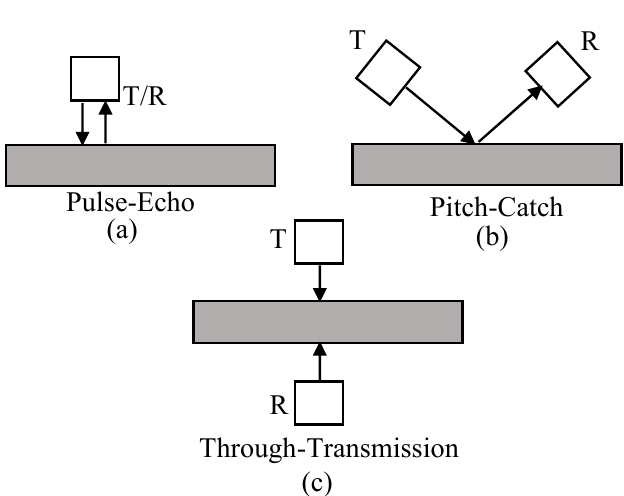
Figure 1. Three most common transmission-reception configurations: ( a ) pulse-echo; ( b ) pitch-catch; and ( c ) through-transmission [41].